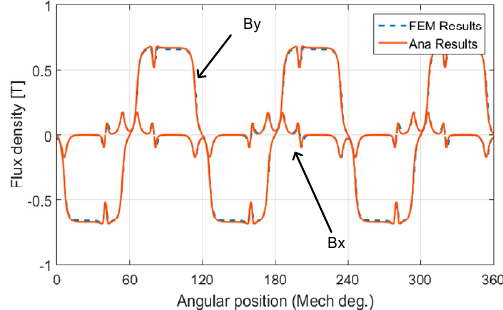
Figure 9. Axial and circumferential components of permanent magnetic (PM) flux density at the center of air gap under no-load condition.